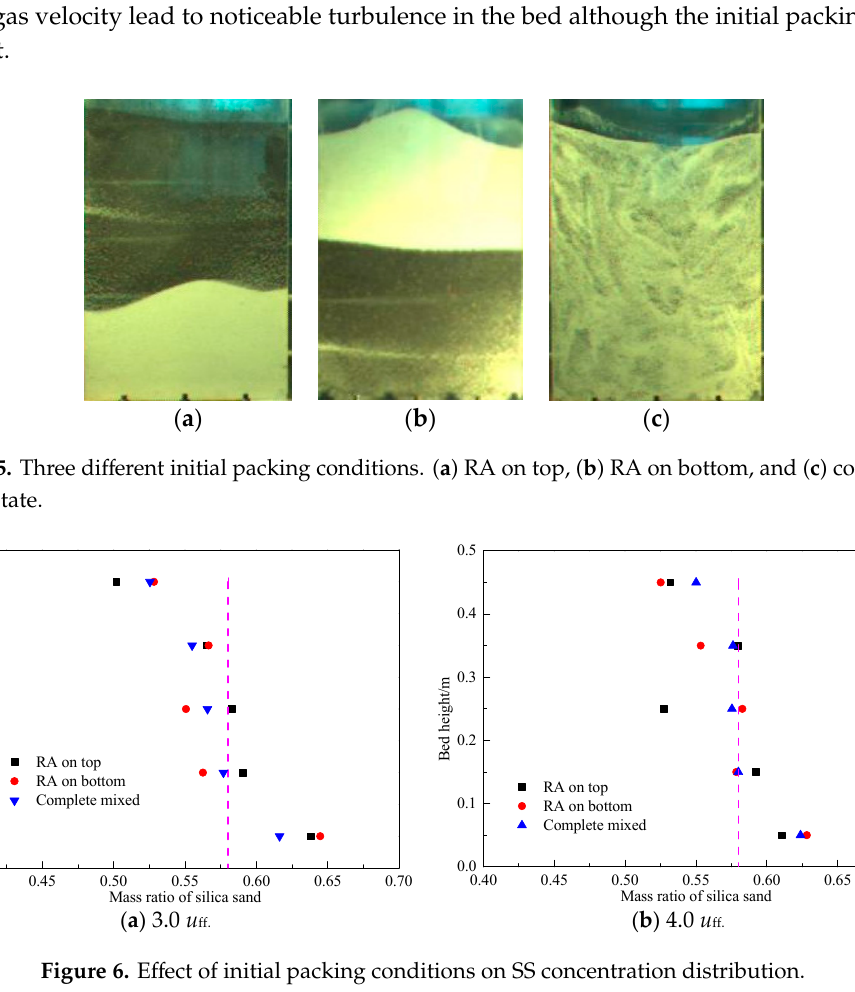
Figure 7. Qualitative mixing states of the binary mixtures ( V b = 0.3).